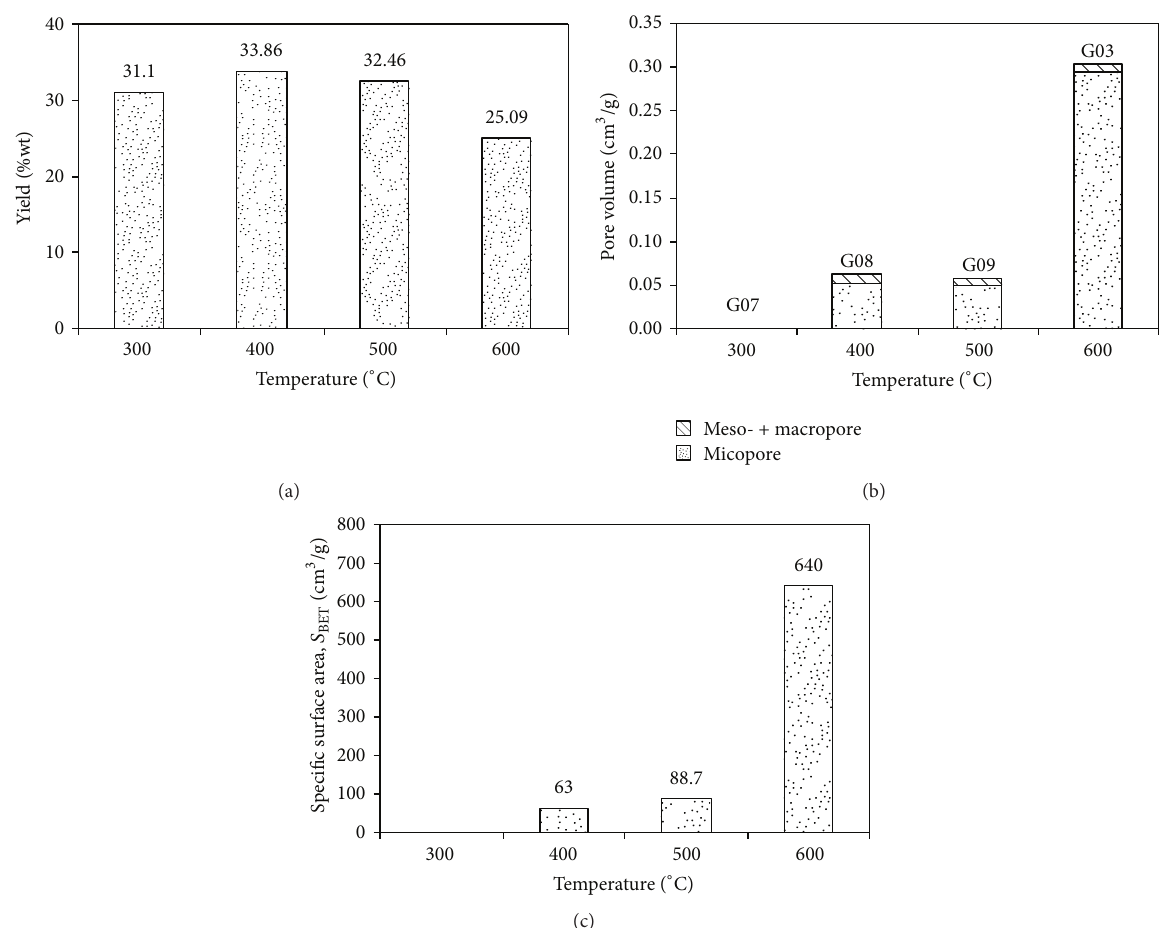
Figure10:Effectofgasificationtemperatureon(a)yield,(b)porevolume,and(c)specificsurfacearea( 𝑆 BET )ofactivatedcarbonfromcoconut shell with the combined use of potassium hydroxide and carbon dioxide at chemical ratio of 0.75, 180min, and without carbonization step.